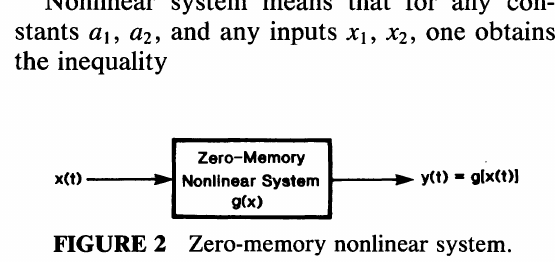
FIGURE 2 Zero-memory nonlinear